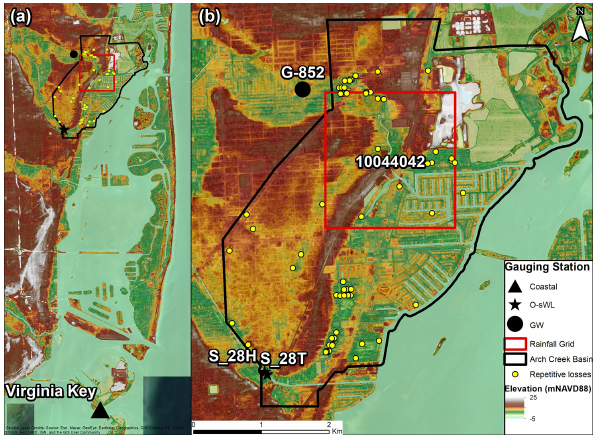
Figure 3. Geographical location of selected data in the study site. (a, b) Topographic map showing the location of the Arch Creek Basin (black polygon) and the distribution of the closest gauging stations to the study site (black markers), rainfall grid (red square) and properties that have experienced severe repetitive losses due to flooding events